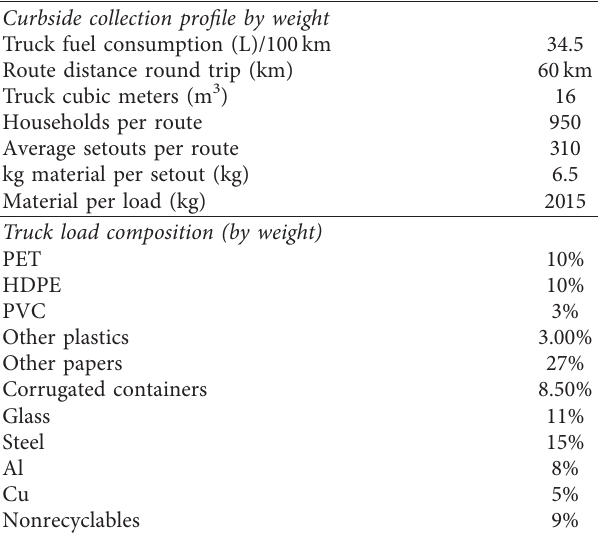
Table 1: Data for the curbside collection profile by weight for the recovery of PET and HDPE and data for composition by weight of materials collected per vehicle load.